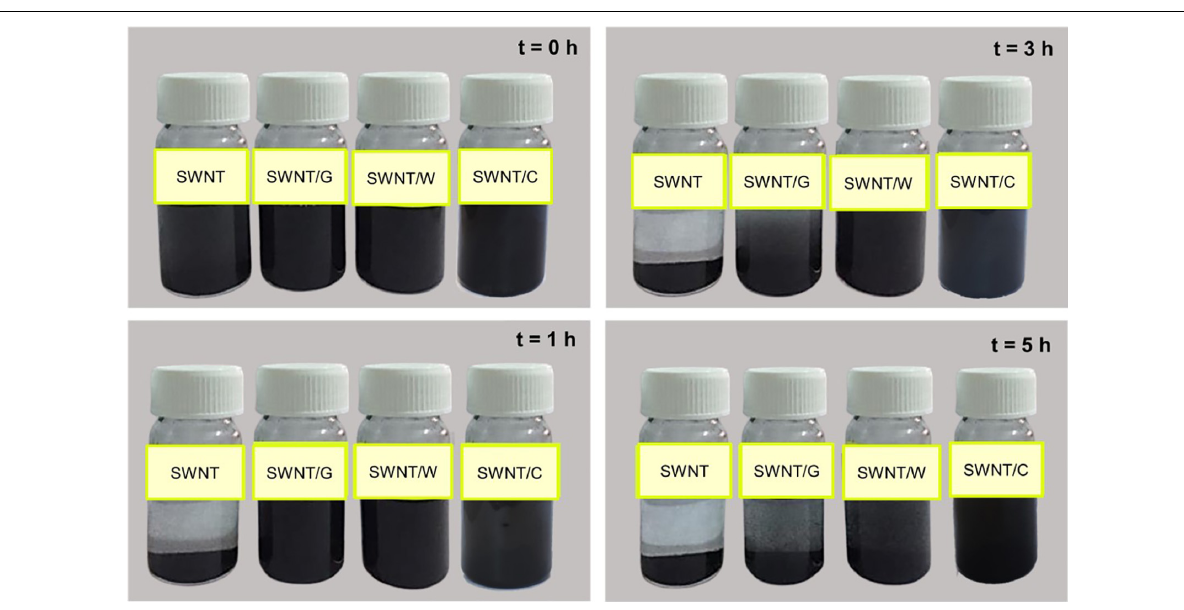
Frontiers in Bioengineering and Biotechnology |